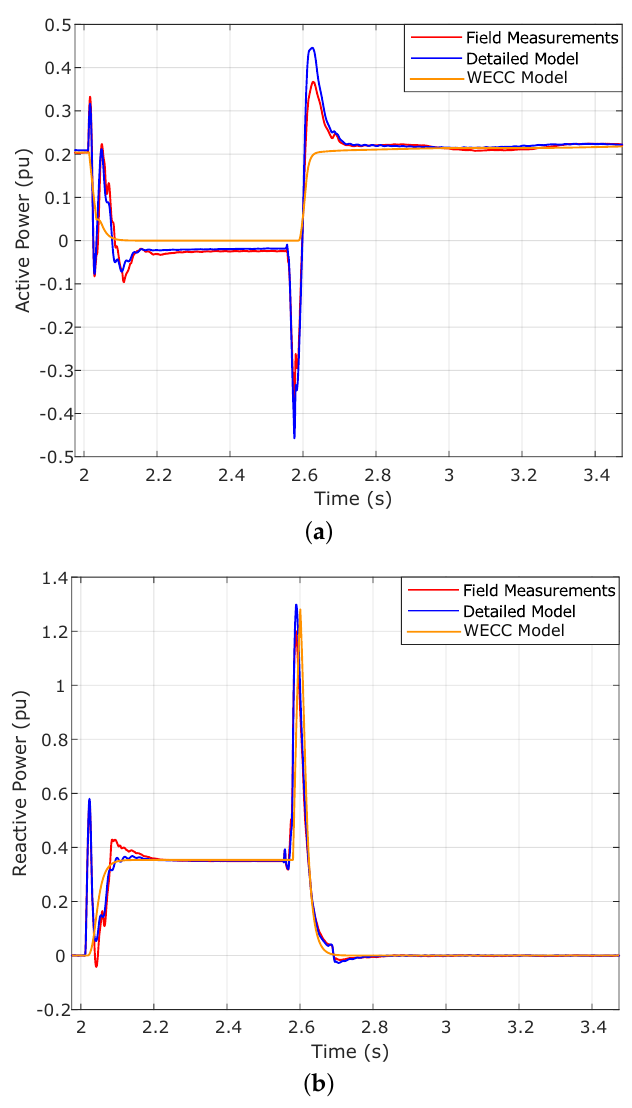
Figure 7. Active and reactive power at measurement point 2 (690 V). WT operating at partial load conditions. ( a ) active power; ( b ) reactive